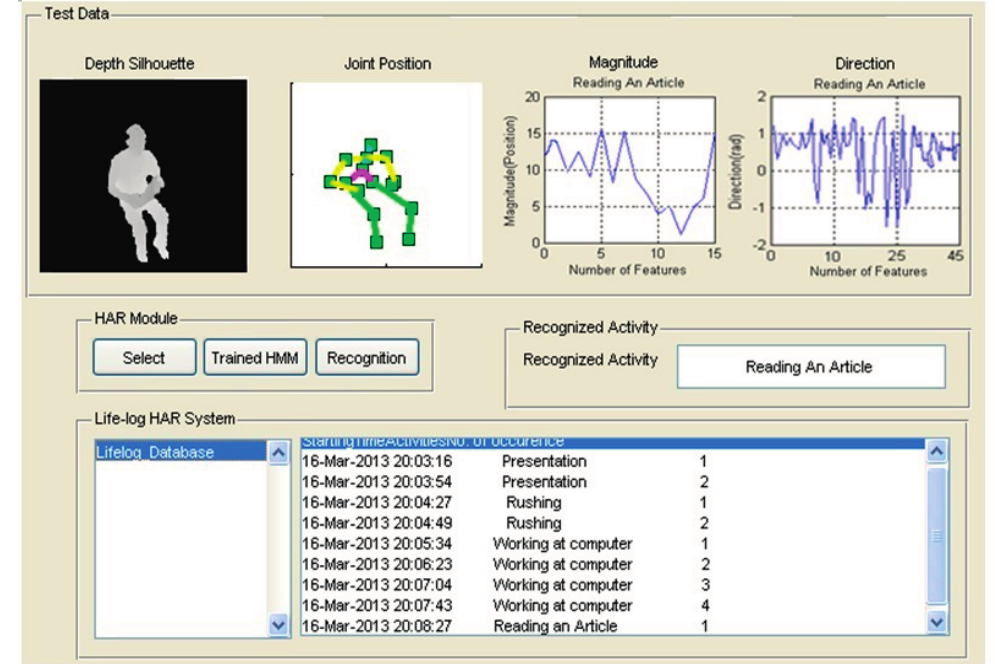
Figure 14. Feature generation and trained via HMM interface using different activities of life logging HAR system.